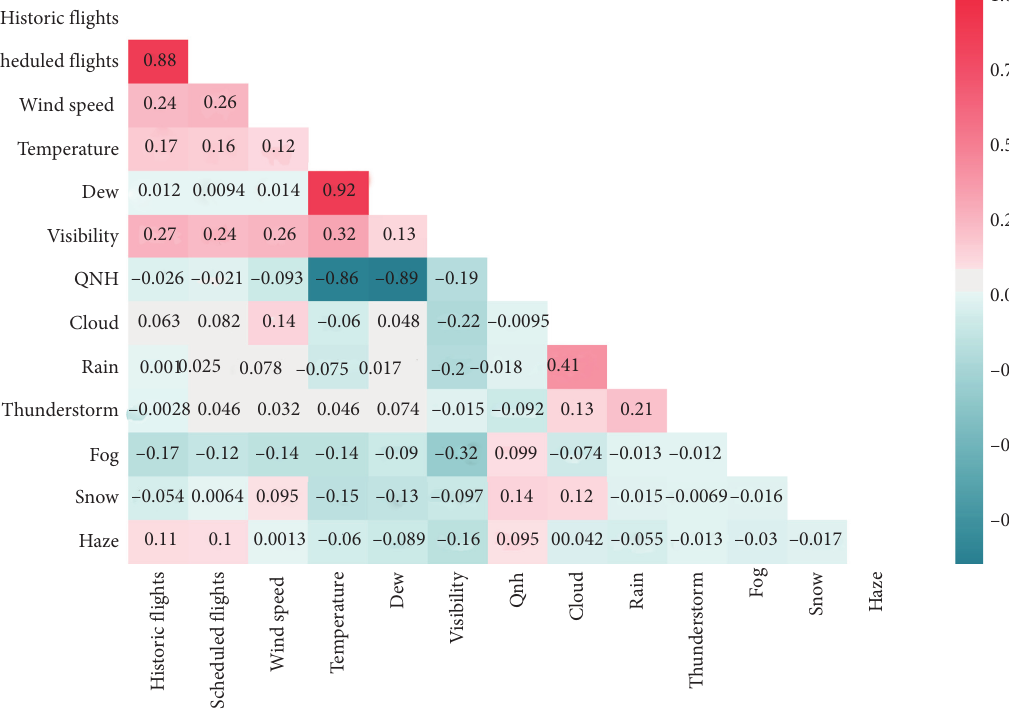
Figure 5: Pearson’s correlation coefficient heat map for the input